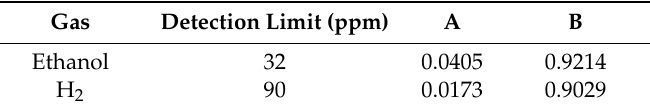
Table 2. Power law calibration coe ffi cients and detection limits of TiO 2 for ethanol and H 2 at optimal working temperatures of 400 ◦ C.